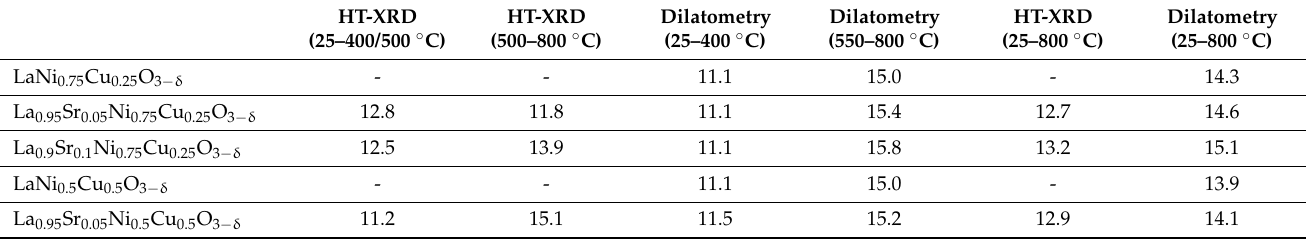
Table 3. Thermal expansion coefficients [10 − 6 K − 1 ] of La 1-x Sr x Ni 1-y Cu y O 3- δ samples from dilatome- try studies and high-temperature XRD measurements in